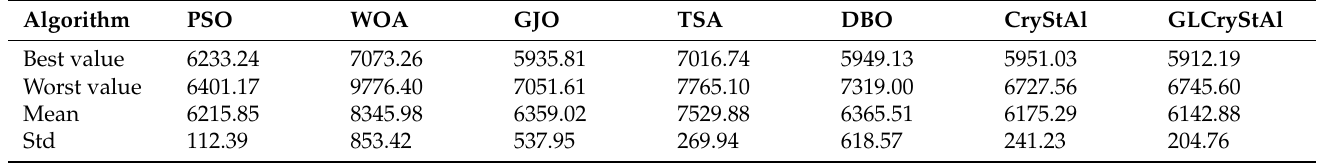
Table 8. Total cost of six algorithms for optimizing pressure vessel design problems.